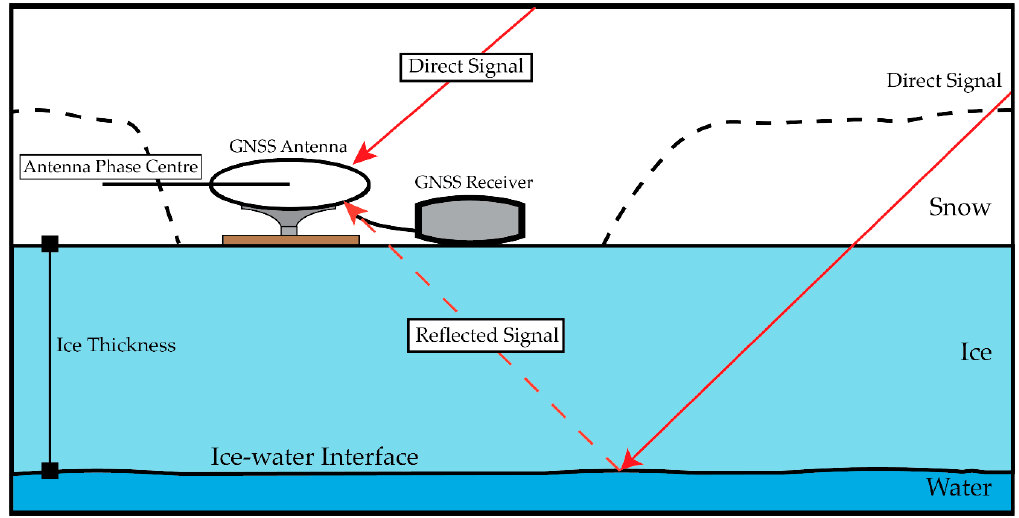
Figure 2. Principle behind the GNSS-IR retrieval approach for the estimation of ice thickness showing the GNSS reflected signal at the ice–water interface.